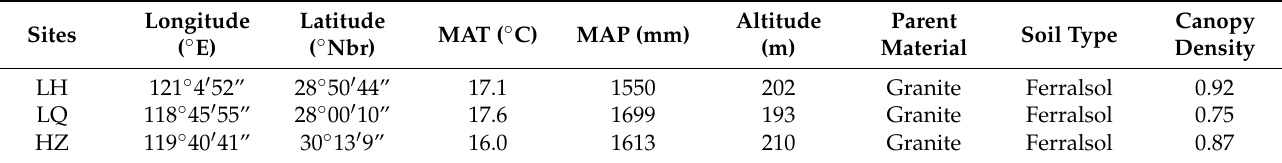
Figure 1. The location of the sampling sites in ZheJiang Province, China. LH, LQ and HZ indicate the sampling sites, respectively. LH: Longtan ao Village, Linhai City; LQ: Baoxi Township, Longquan City; HZ: Linglong Mountain, Hangzhou City. Table 1. Geographical coordinates, altitude, MAT, MAP and soil types of the study sites.